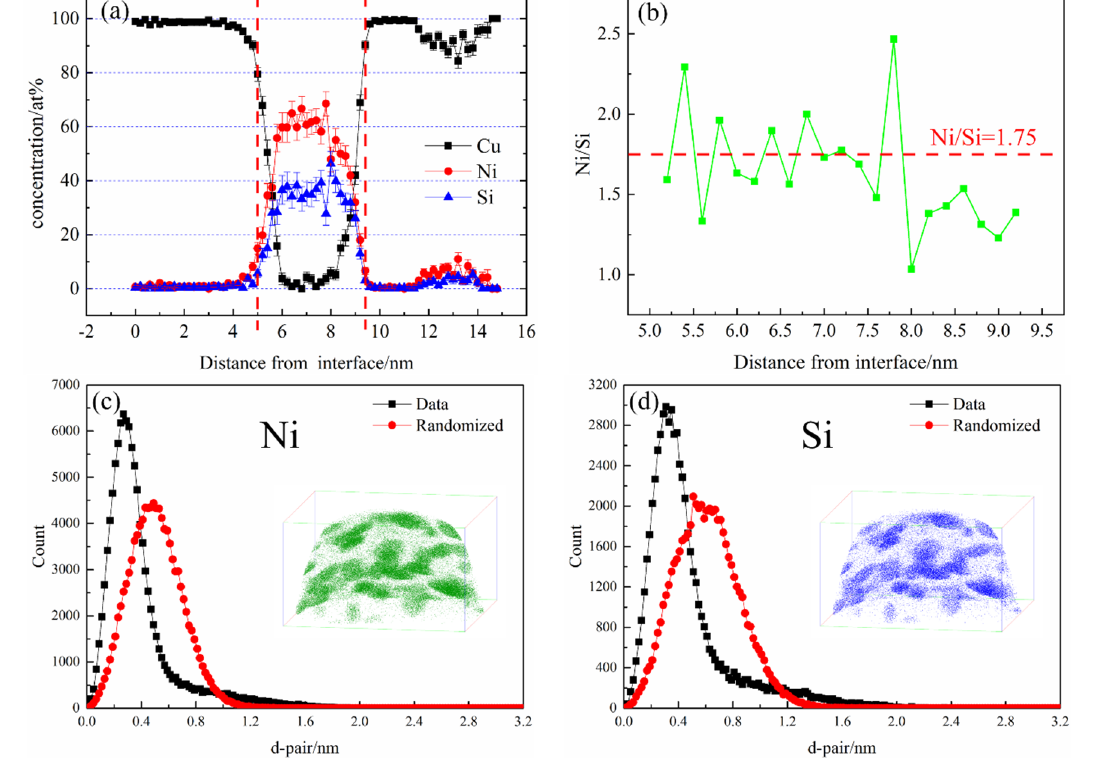
Figure 11. Atomic concentration distribution profiles and nearest neighbor distribution (NND) curves of the NS-4 alloy. ( a ) Atomic concentration distribution profiles, ( b ) enlarged area of the dotted line in ( a ), ( c ) NND curves of Ni and ( d ) NND curves of Si.